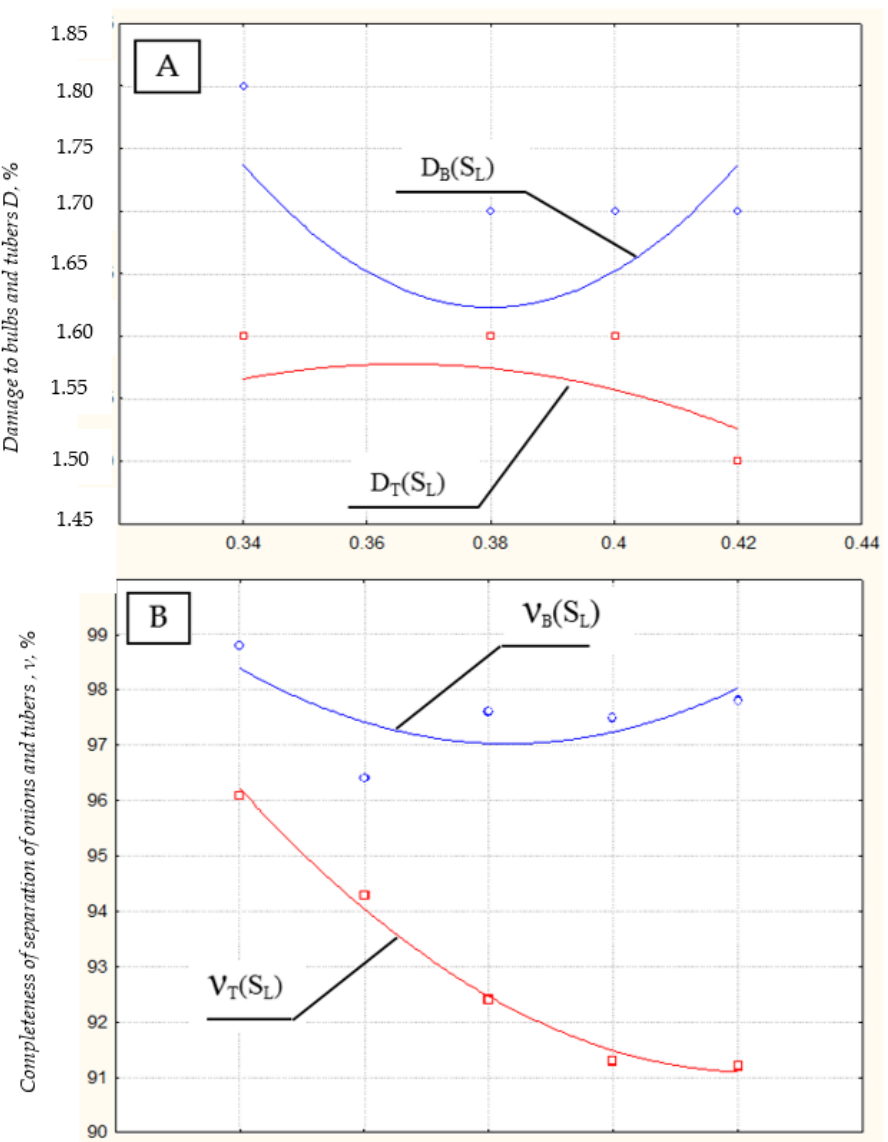
Figure 8. Dependence of: ( A ) damage to bulbs D B and tubers D T , %; and ( B ) completeness of separation of onions ν B and tubers ν T % of the separating rod elevator with an adjustable blade inclination angle from the center distance S L between the